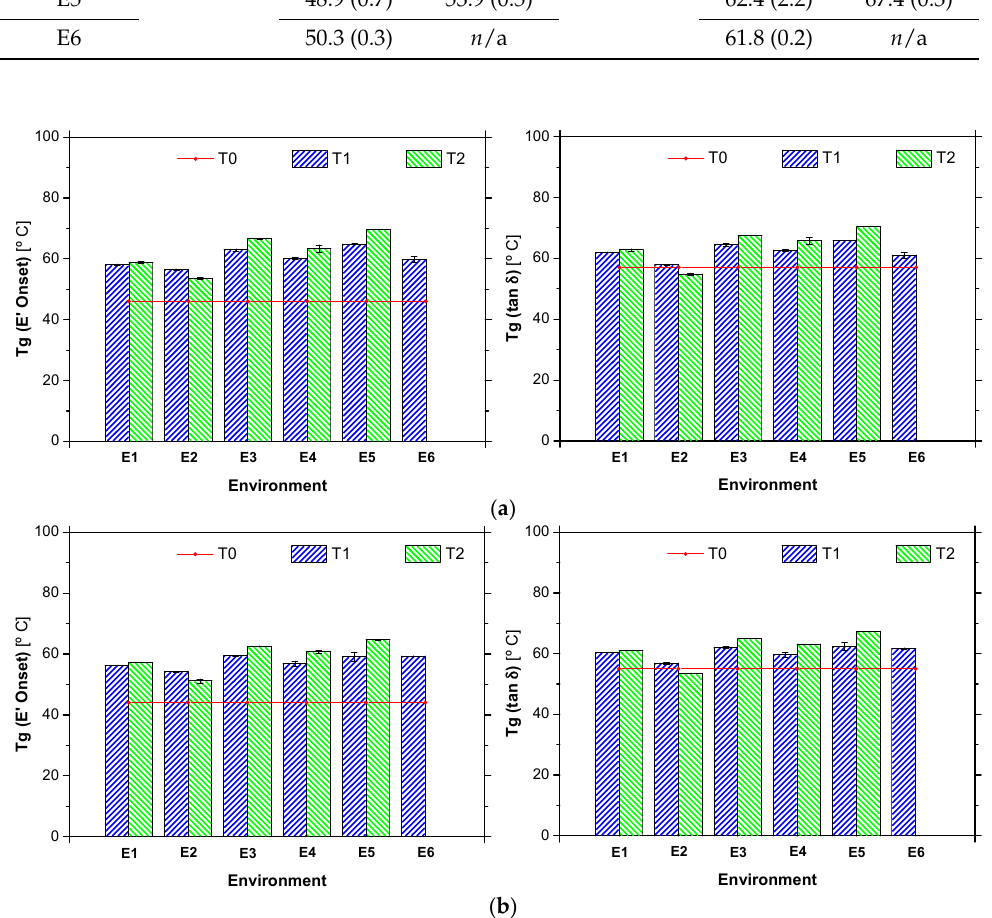
Figure 11. Glass transition temperature of adhesives ( a ) ADH1 and ( b ) ADH2, after one year (T1) and two (T2) years of exposure to the environments studied (E1 to E6), including the reference (cured at 23 °C, 7 days).